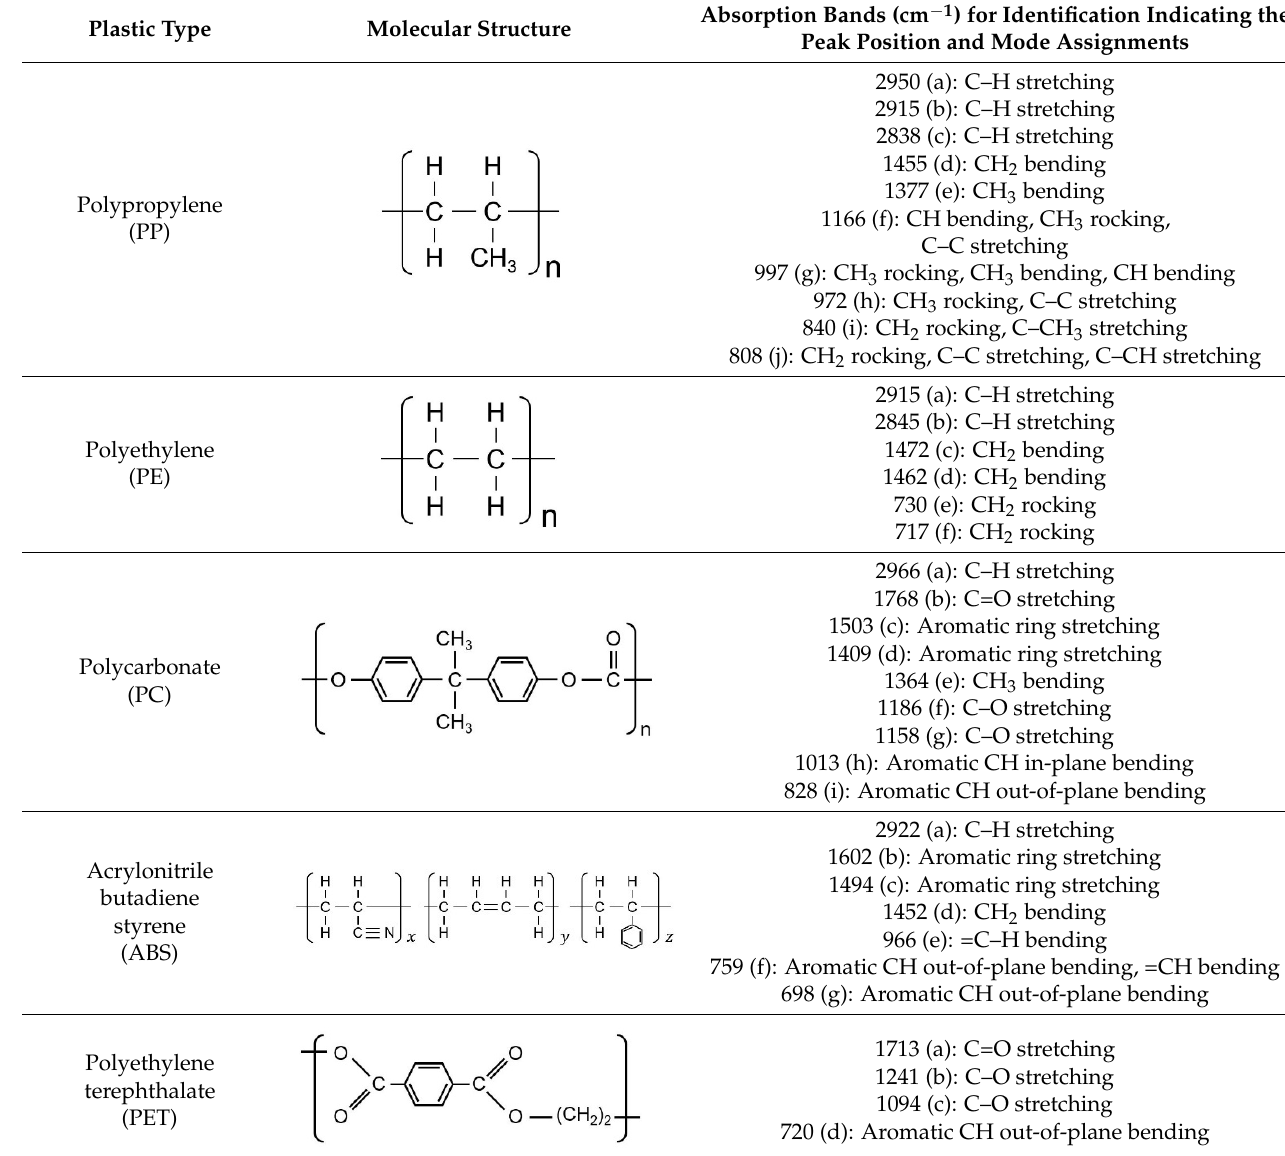
Table 6. List of important vibration modes and mode assignments for the FT-IR spectra [45]. Plastic Type